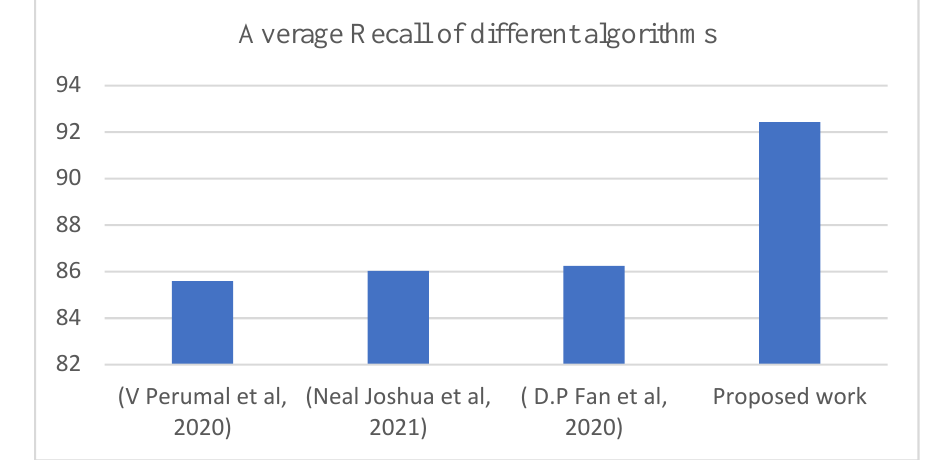
Figure 13. Average recall for different algorithms from [7,19,28], and proposed work. Table 4. Test fMeasure for combined dataset. No. of Images